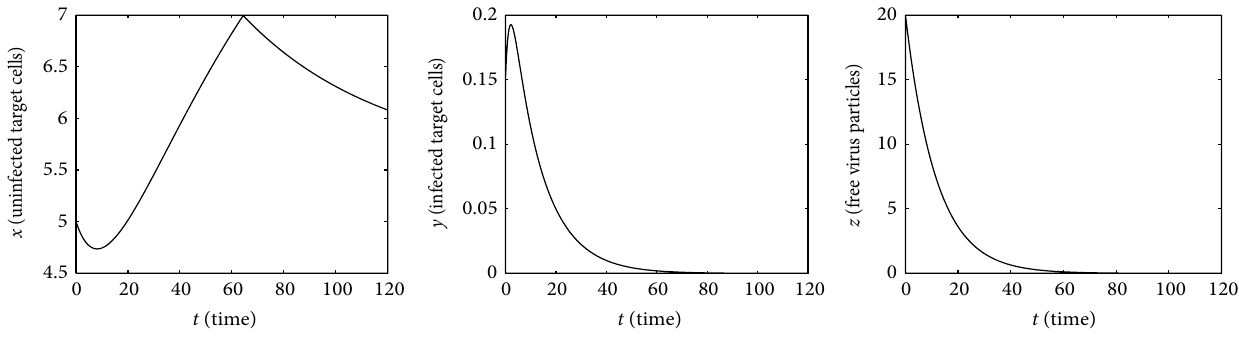
Figure 7: Optimal solutions for 푇 = 120.0 : 푥